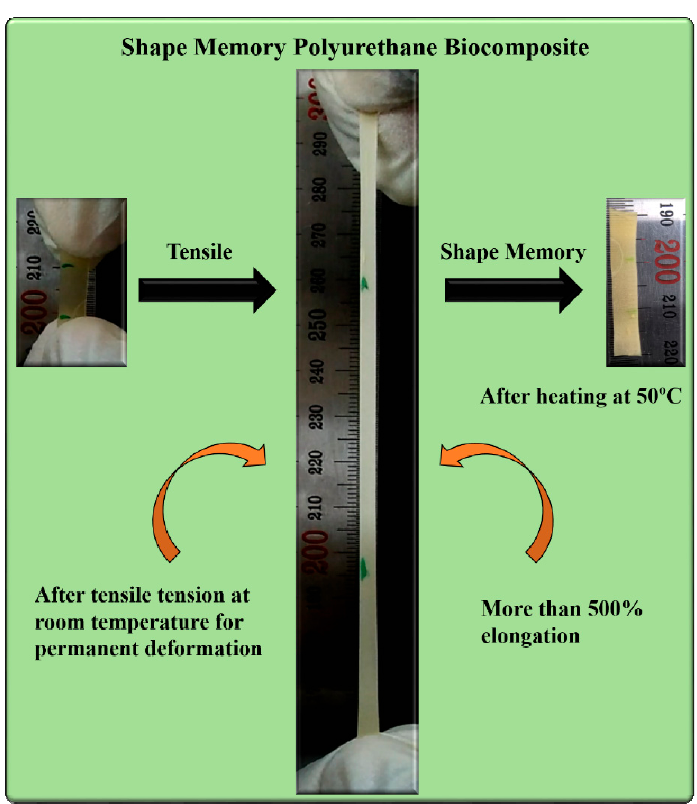
Figure 11. Shape memory behavior of the polyurethane chitosan biocomposite after tensile